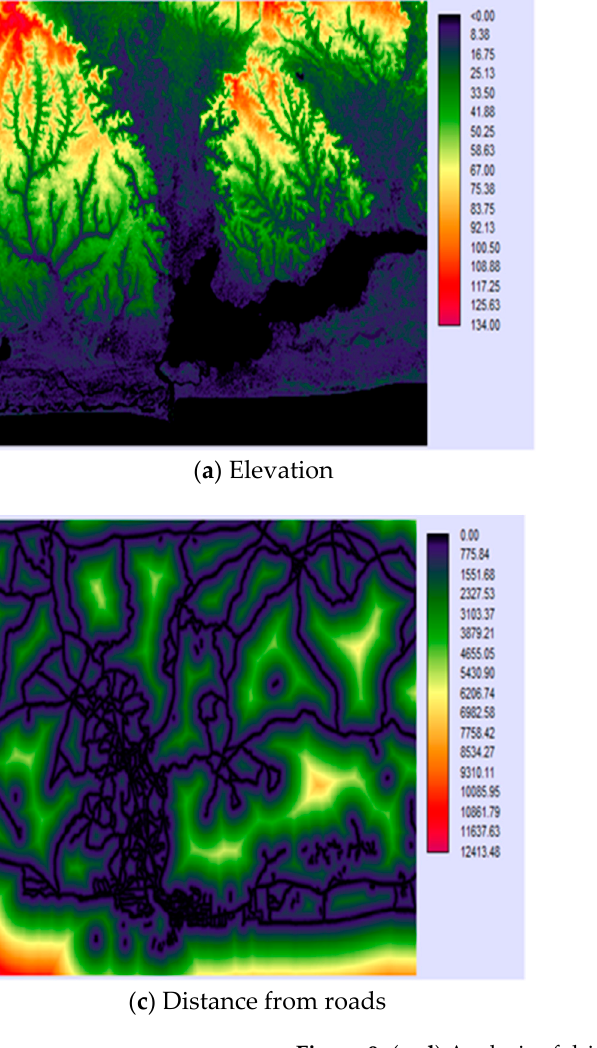
Figure 9. ( a – d ) Analysis of driving factors of LULC change.